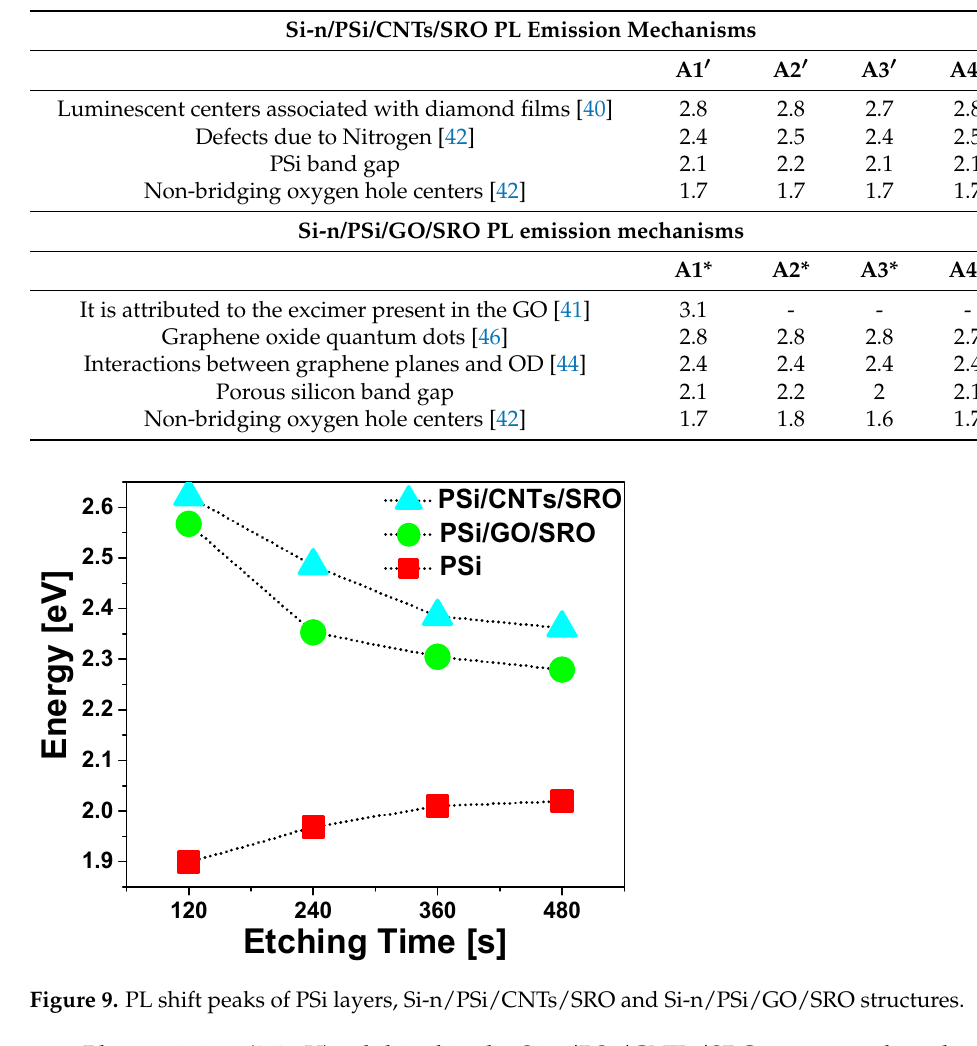
Table 5. Types of defects linked to the position [eV] of the PL peaks of the structures.